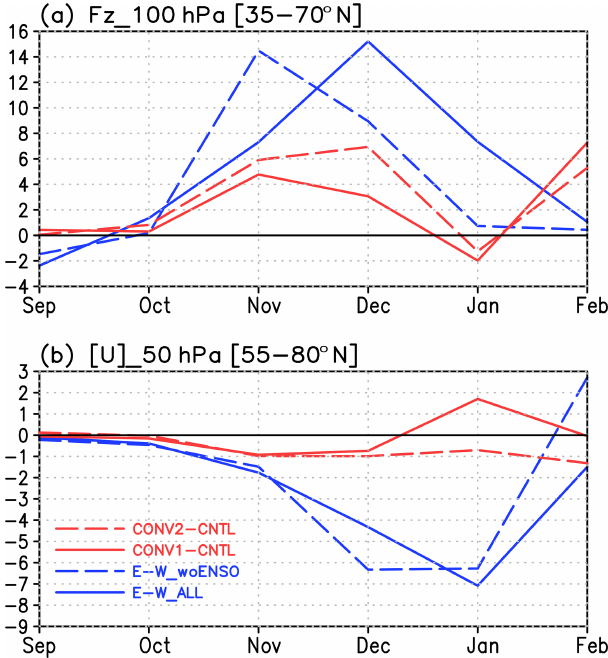
Figure 16. (a) Time series of upward EP flux ( F z ) at 100hPa aver- aged over 35–70 ◦ N. Unit is 1 × 10 3 kgs − 2 . The solid (dotted) blue line shows observed difference between EQBO and WQBO winters (without ENSO winters). The solid (dotted) red line shows differ- ence between CONV1 (CONV2) and CNTL experiments. (b) Time series of zonal-mean zonal wind [ U ] difference at 50hPa averaged over 55–80 ◦ N between EQBO and WQBO winters. Unit is ms − 1 . The solid (dotted) blue line shows the difference with all years (without ENSO winters). The solid (dotted) red line shows differ- ence between the CONV1 (CONV2) and CNTL